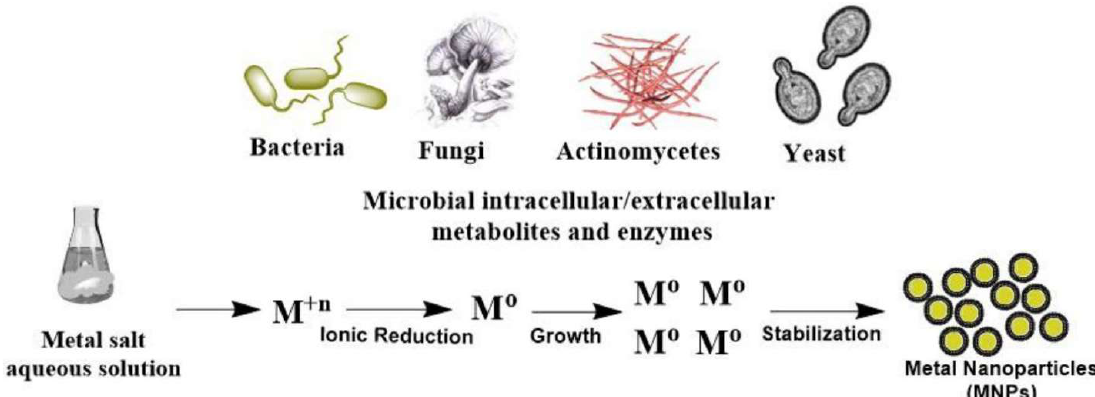
Figure 3. The overall mechanism of green synthesis of metal nanoparticles through natural reduction of metallic ions by microbial enzymes [49]. Reprinted with permission.